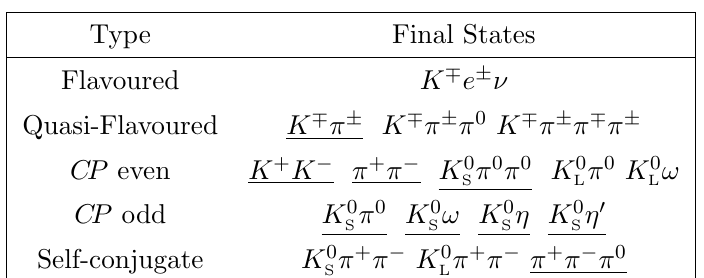
Figure 4 . The model predictions of the Q values found from all binning schemes considered in this paper. The uncertainties are found by varying the model predictions of the hadronic parameters within their uncertainties.